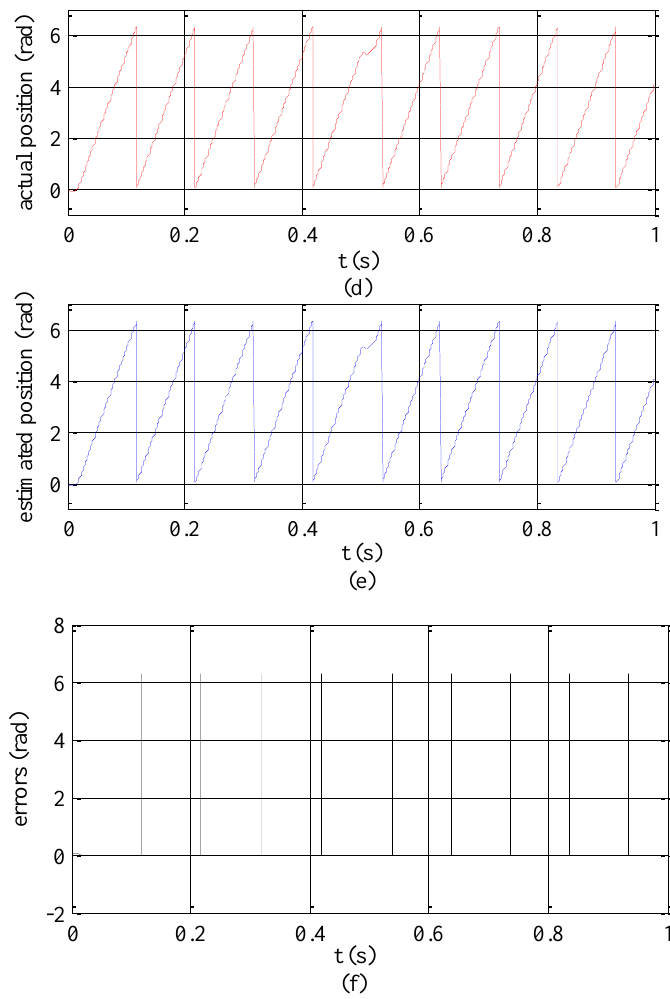
Figure 9. Waveforms of rotor position: ( a ) actual rotor position with speed changes; ( b ) estimated rotor position with speed changes; ( c ) errors between actual rotor position and estimated rotor position with speed changes; ( d ) actual rotor position with torque changes; ( e ) estimated rotor position with torque changes; ( f ) errors between actual rotor position and estimated rotor position with torque changes.